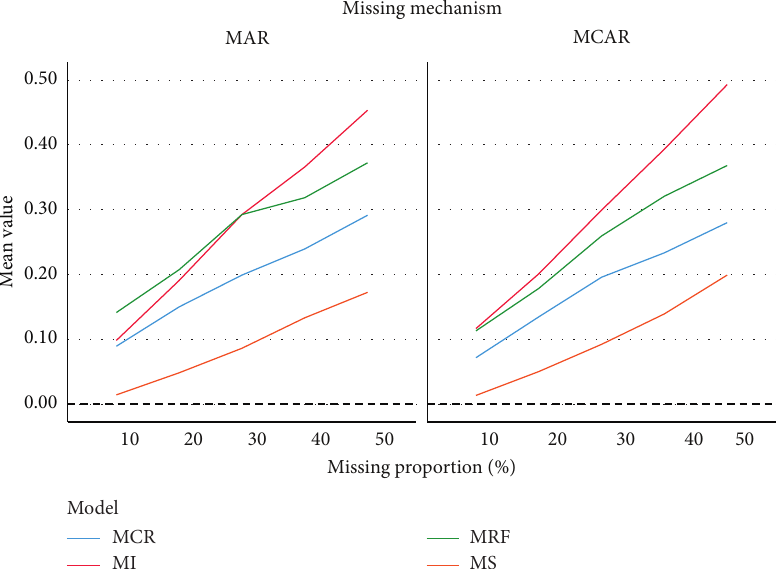
Figure 6: Comparison of the performance of imputation methods for real dataset based on the proportion of the variation attributable to the missing data ( λ ) for the interaction effect.